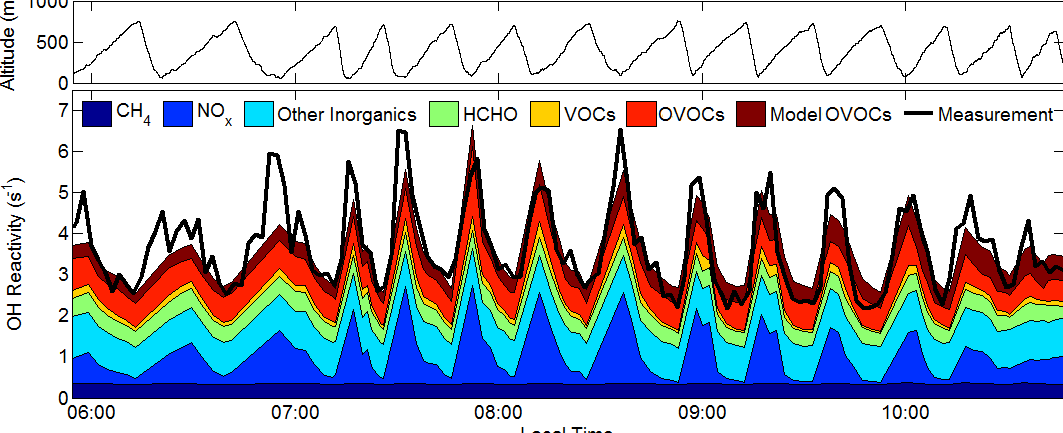
Figure 4. Contributions to calculated OH reactivity as a function of time. Only data acquired during the ascents are used in the calcu- lated reactivity. The VOC category consists of isoprene, toluene, benzene, xylenes, ethylbenzene, C4–C9 straight chain alkanes, styrene, trimethylbenzene, 1-pentene, cis-2-pentene, cyclohexanone, propylbenzene, isopropylbenzene, isopentane, benzaldehyde, and 1-butene. The OVOC category consists of C2–C6 straight chain aldehydes, acetone, methanol, ethanol, methyl acetate, ethyl acetate, methacrolein, methyl ethyl ketone, methyl vinyl ketone, and 1-propanol. The inorganics category consists of CO, H 2 , HONO, HO 2 , and O 3 . Model OVOCs are non-measured oxidation products calculated by the